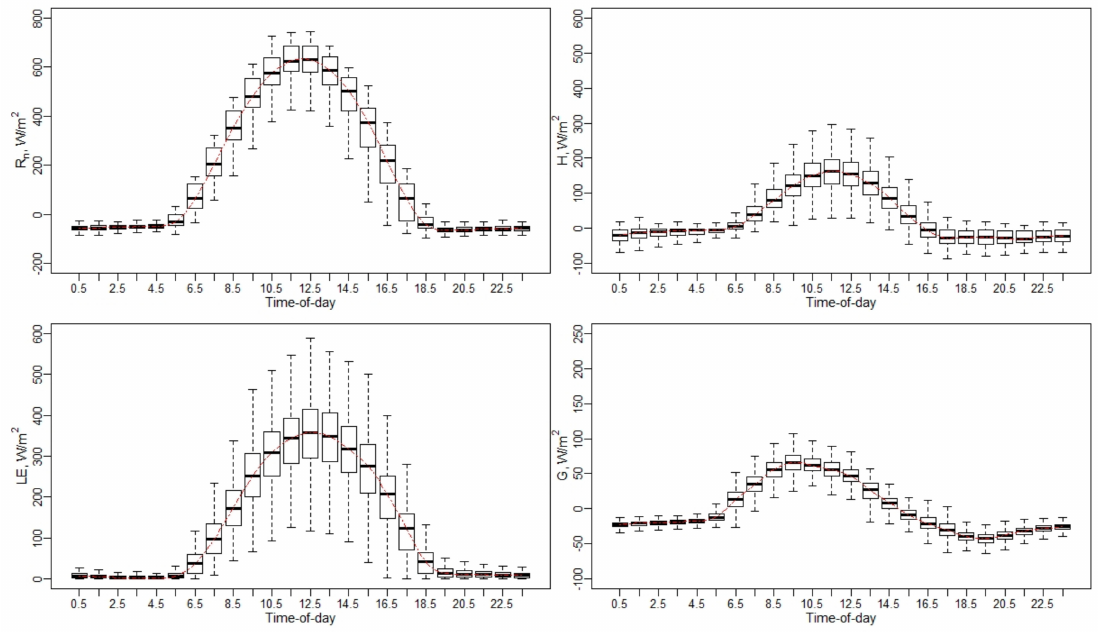
Figure A12. Diurnal variation of surface energy fluxes ( R n , H , LE , and G